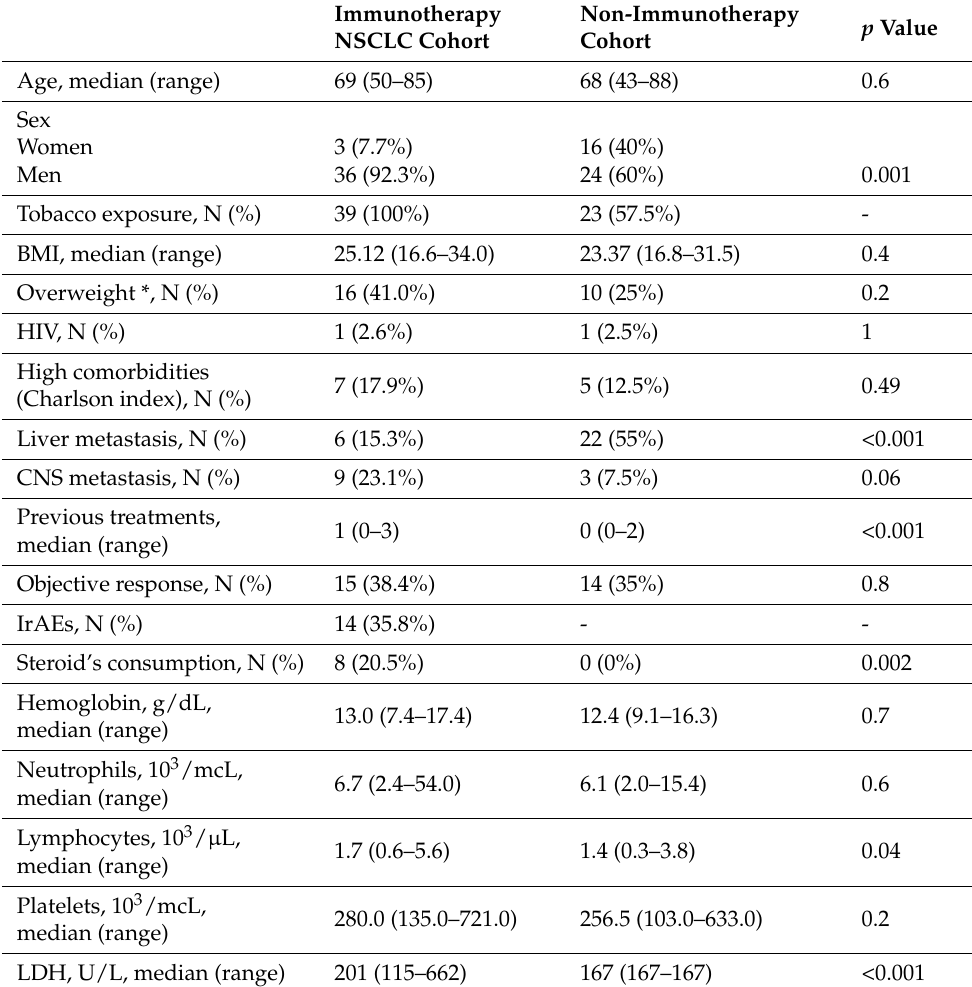
Table 2. Clinical and demographic characteristics of the study and control groups. *